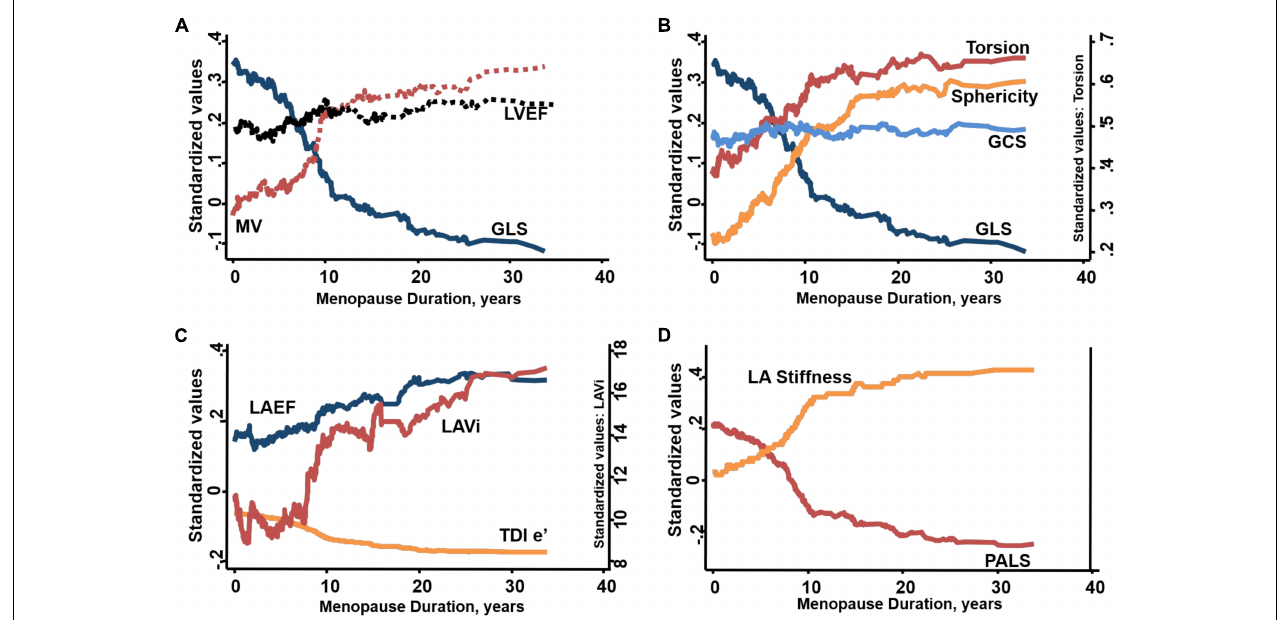
FIGURE 3 | Duration of menopause-associated changes in (A) increased LV mass-to-volume ratio (MV) and worsened global longitudinal strain (GLS) with relatively unchanged LV ejection fraction (LVEF), (B) sphericity at end-diastole accompanied by greater torsion despite worsened GLS and relatively unchanged global circumferential strain (GCS), (C) worsened myocardial relaxation e’, greater indexed LA volume and relatively unchanged LA emptying fraction (LAEF), (D) worsened global peak LA strain (PALS) and greater LA stiffness in post-menopause women with time to onset of menopause available.